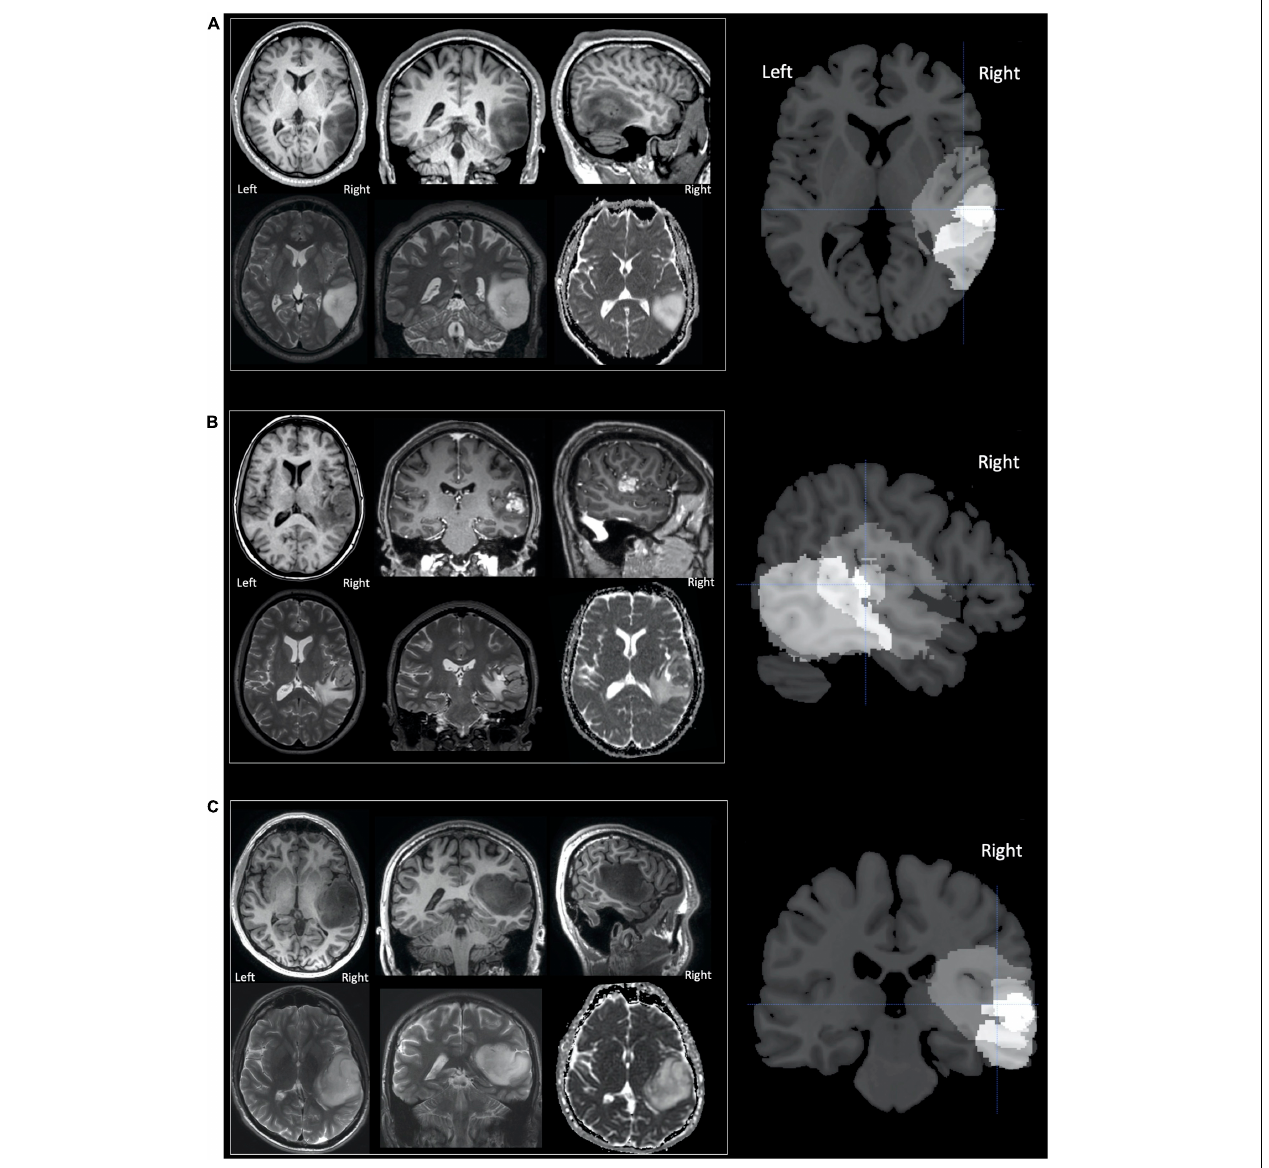
FIGURE 1 | Tumours in patients (A–C) . Selected MR images for patients (A–C) are shown in neurological convention, with the right of the image corresponding to the right of the patient. The upper row, for each patient, displays (from left to right) axial, coronal and sagittal T1-weighted images. For patients A and C only unenhanced sequences are shown as their tumours were both non-enhancing. For patient B the coronal and sagittal images T1-weighted images are contrast enhanced and display a central enhancing component. The lower row for each patient (from left to right), displays axial and coronal T2-weighted images and the axial apparent diffusion coefficient (ADC) image from the diffusion weighted imaging (DWI). The right column of images shows sections from the lesion overlap map demonstrating the three tumours superimposed on one another—brighter voxels indicate more overlap between the three tumours. The overlap was greatest in the region of the superior temporal sulcus with the cross hair centred at [+51 − 25 +5] which showed significantly altered activation during the speech perception and production tasks (see section